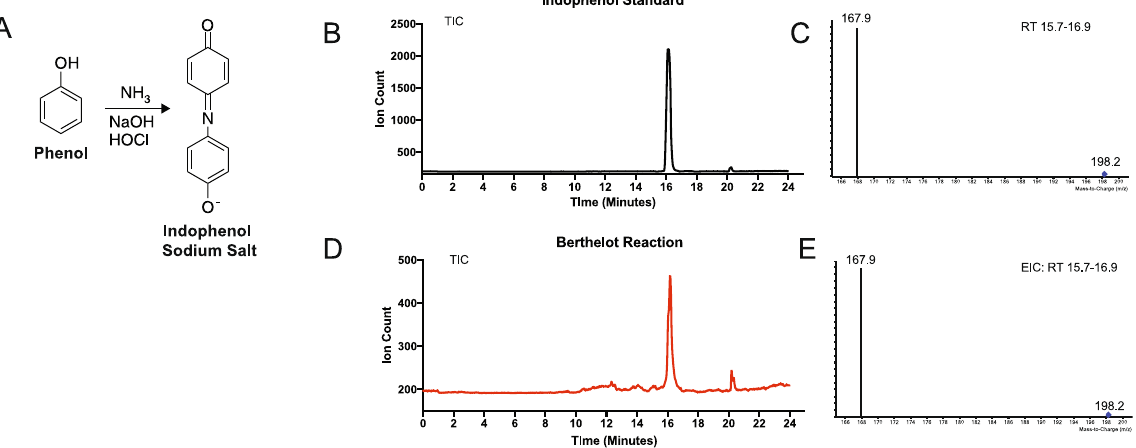
Figure 1. Indophenol Generated from The Berthelot Reaction is detected with LC-MS. ( A ) Schematic of the Berthelot Reaction, which generates indophenol from ammonia. ( B ) Total ion chromatogram of an indophenol standard (1 u g/mL). ( C ) Mass spectrum for the retention time window 15.7–16.9 minutes of the total ion chromatogram of the indophenol standard ( D ) Total ion chromatogram of 500 μ M ammonia after the Berthelot reaction. ( E ) Mass spectrum for the retention time window 15.7–16.9 minutes of the total ion chromatogram of the Berthelot